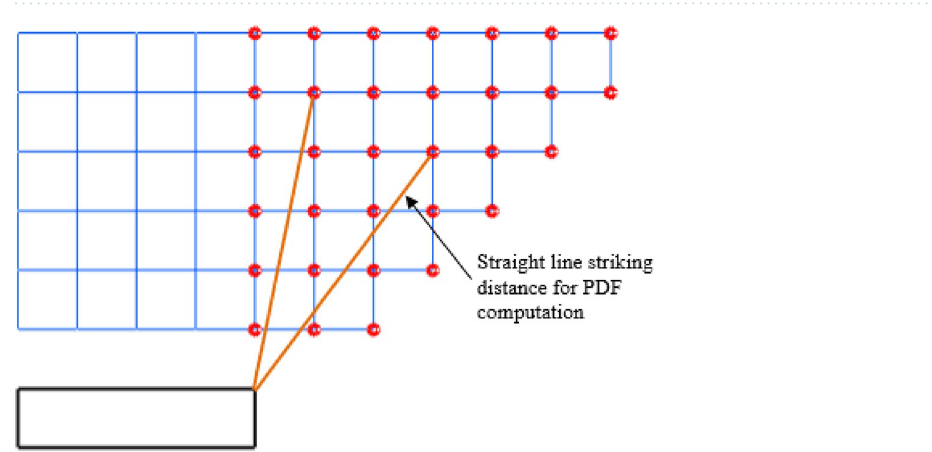
Figure 4. Superfluous space points with strikes to the ground together with needed space points with strikes to the structure at the corner area of the space point layers.